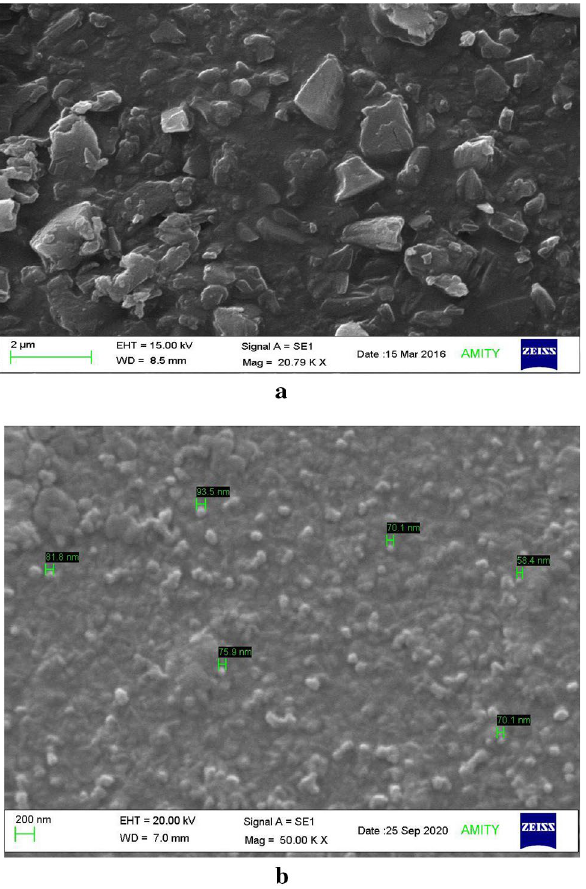
Figure 3. SEM images showing the difference in surface morphological, shape, and size of ( a ) curcumin powder; ( b ) and nanocurcumin particles.